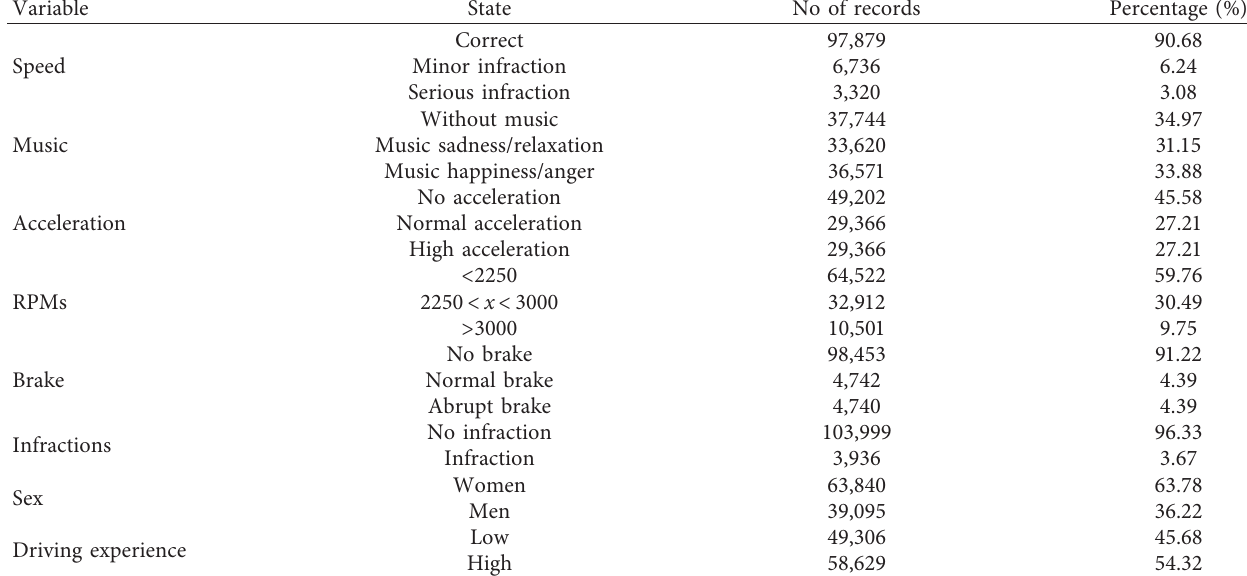
Table 4: Table of records.